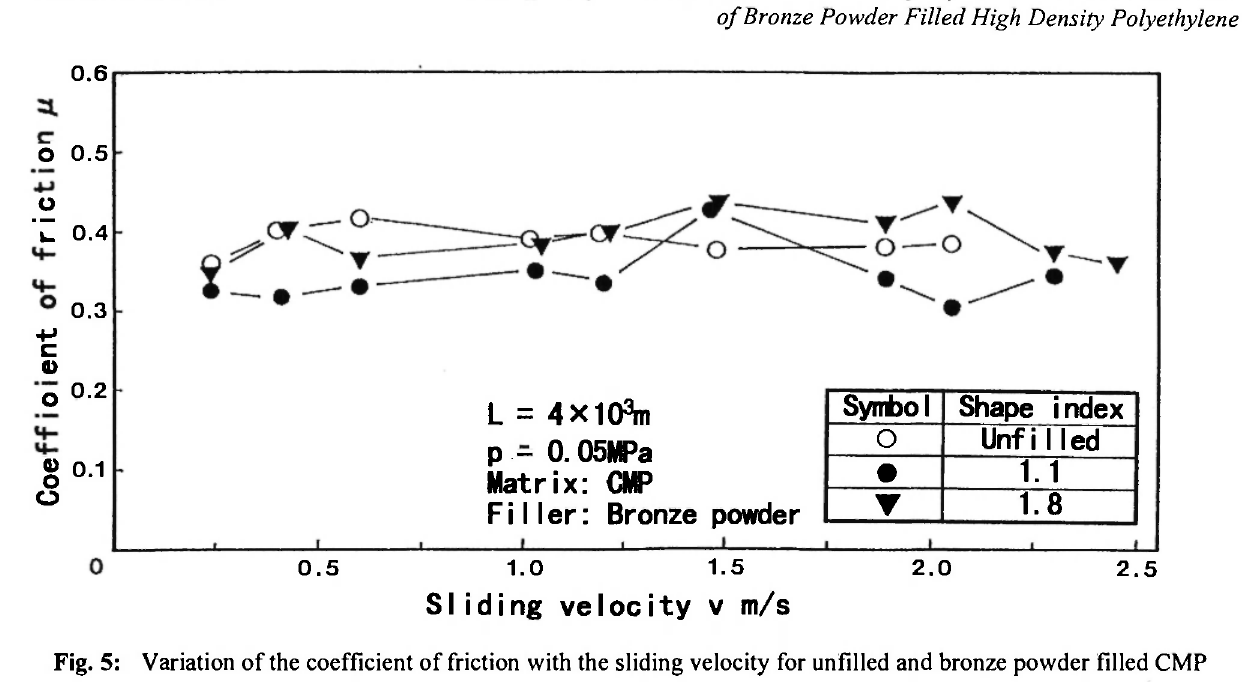
Fig. 5: Variation of the coefficient of friction with the sliding velocity for unfilled and bronze powder filled CMP